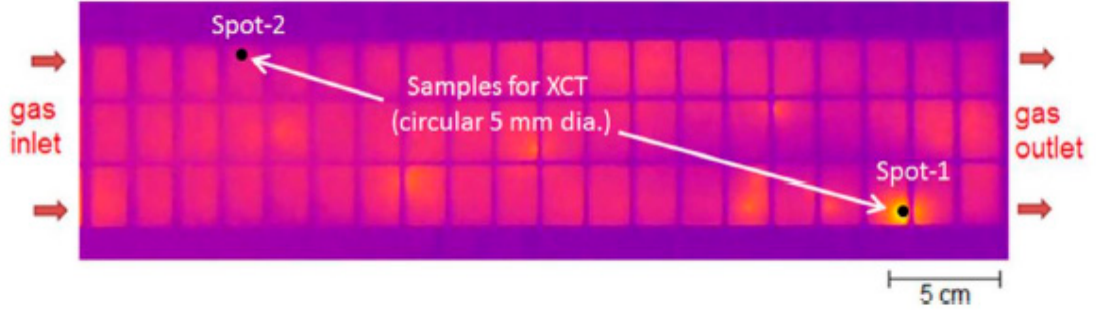
Figure 4. Infrared image of failure MEA in pure chemical degradation [17].